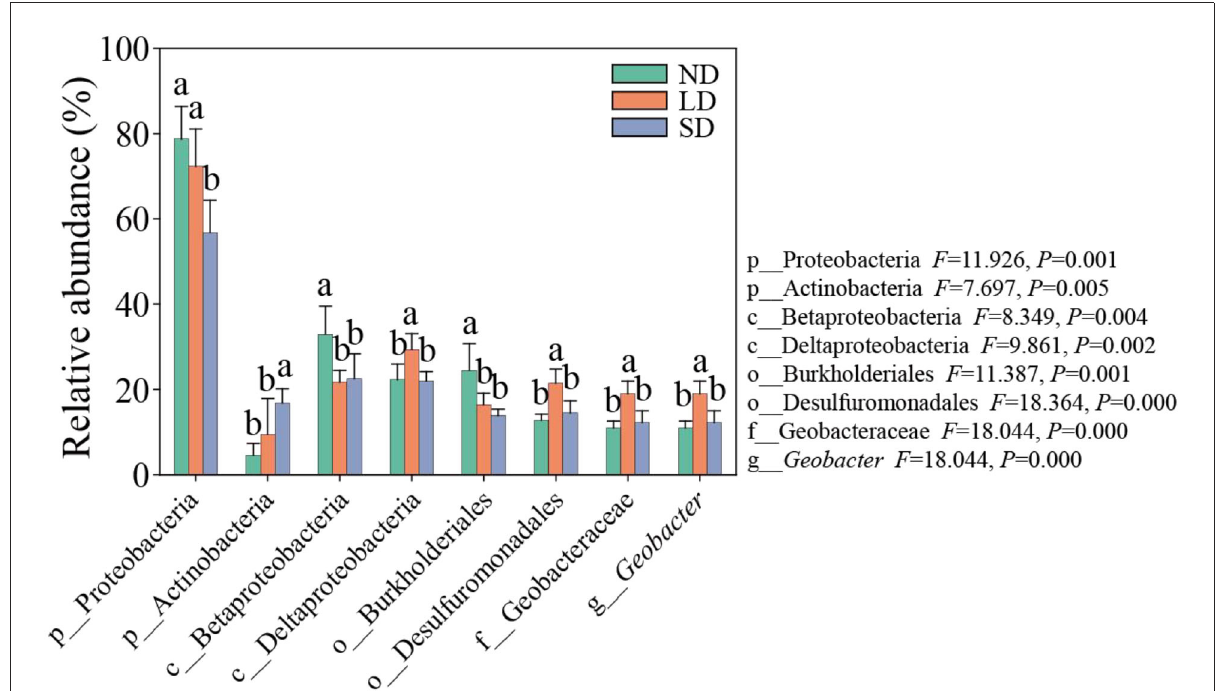
FIGURE5 Abundance of main species of nitrogen-fixing bacteria. ND is non-degradation and LN and SD are the light and severe degradation stages of the alpine wetland, respectively. Different lowercase letters represent significant differences between different degradation